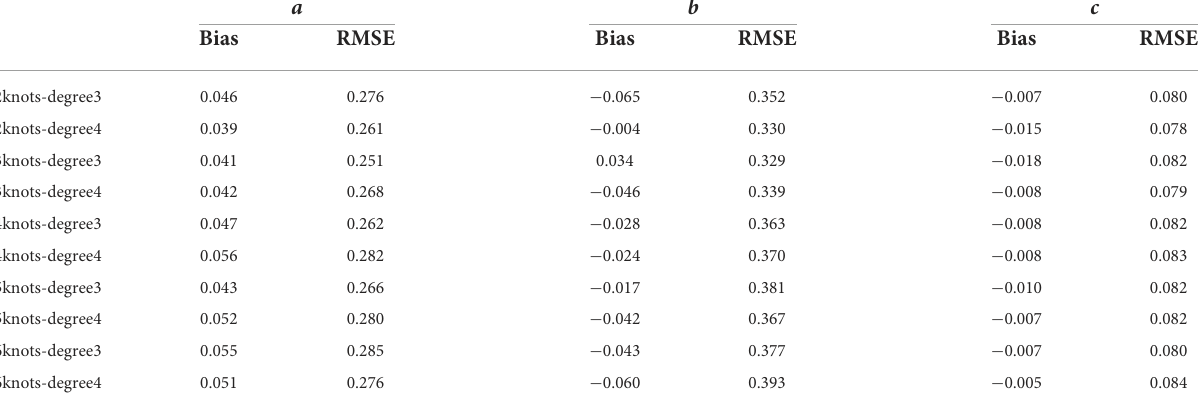
TABLE 3 Bias and RMSE of item parameter estimates under different combinations of knots and degree in skewed case. a